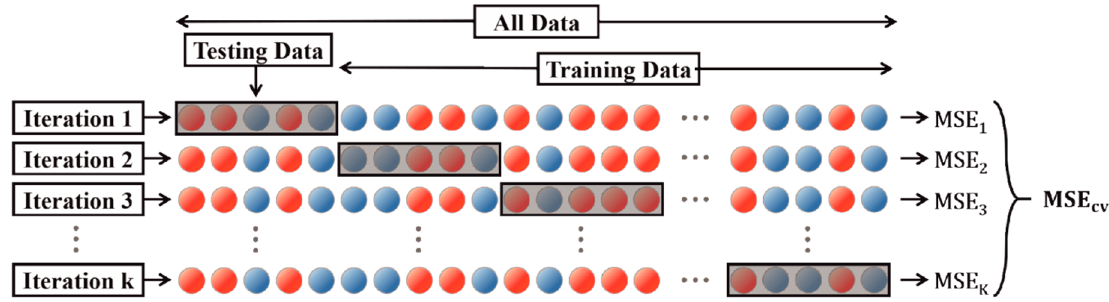
Figure 2. Representation of the k-fold cross-validation process.